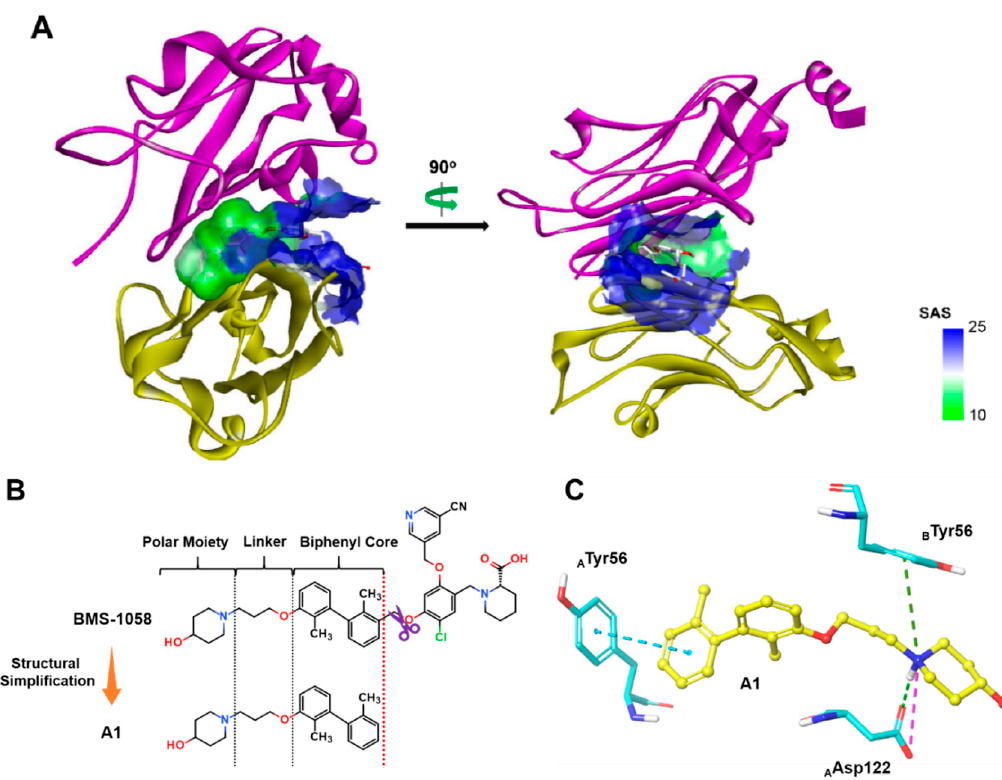
Figure 2. ( A ) Crystal structure of PD-L1 (chain A, yellow; chain B, purple)/BMS-202(white) complex (PDB code: 5J89). Receptor surfaces, covering atoms that are close to the current ligand, are colored by solvent accessibility surface (SAS). The default color spectrum used is green–white–blue, and small values (green) correspond to buried residues, whereas large values (blue) correspond to exposed residues. This picture was drawn by Discovery Studio Visualizer [29]. ( B ) Strctural simplification strategy of this work. ( C ) Putative binding modes of A1 in the binding pocket of PDL1 dimer structure. Dashed lines represent the inter-interaction between A1 and protein, specifically, green ones indicate hydrogen bond, dark green ones indicate cation– π interaction, purple ones indicate ionic interaction, and sky-blue ones indicate π – π interaction. Table 1. Activities of compounds A1 – A4 in inhibition of the PD-1/PD-L1 interaction. CH 3 Linker N R 1